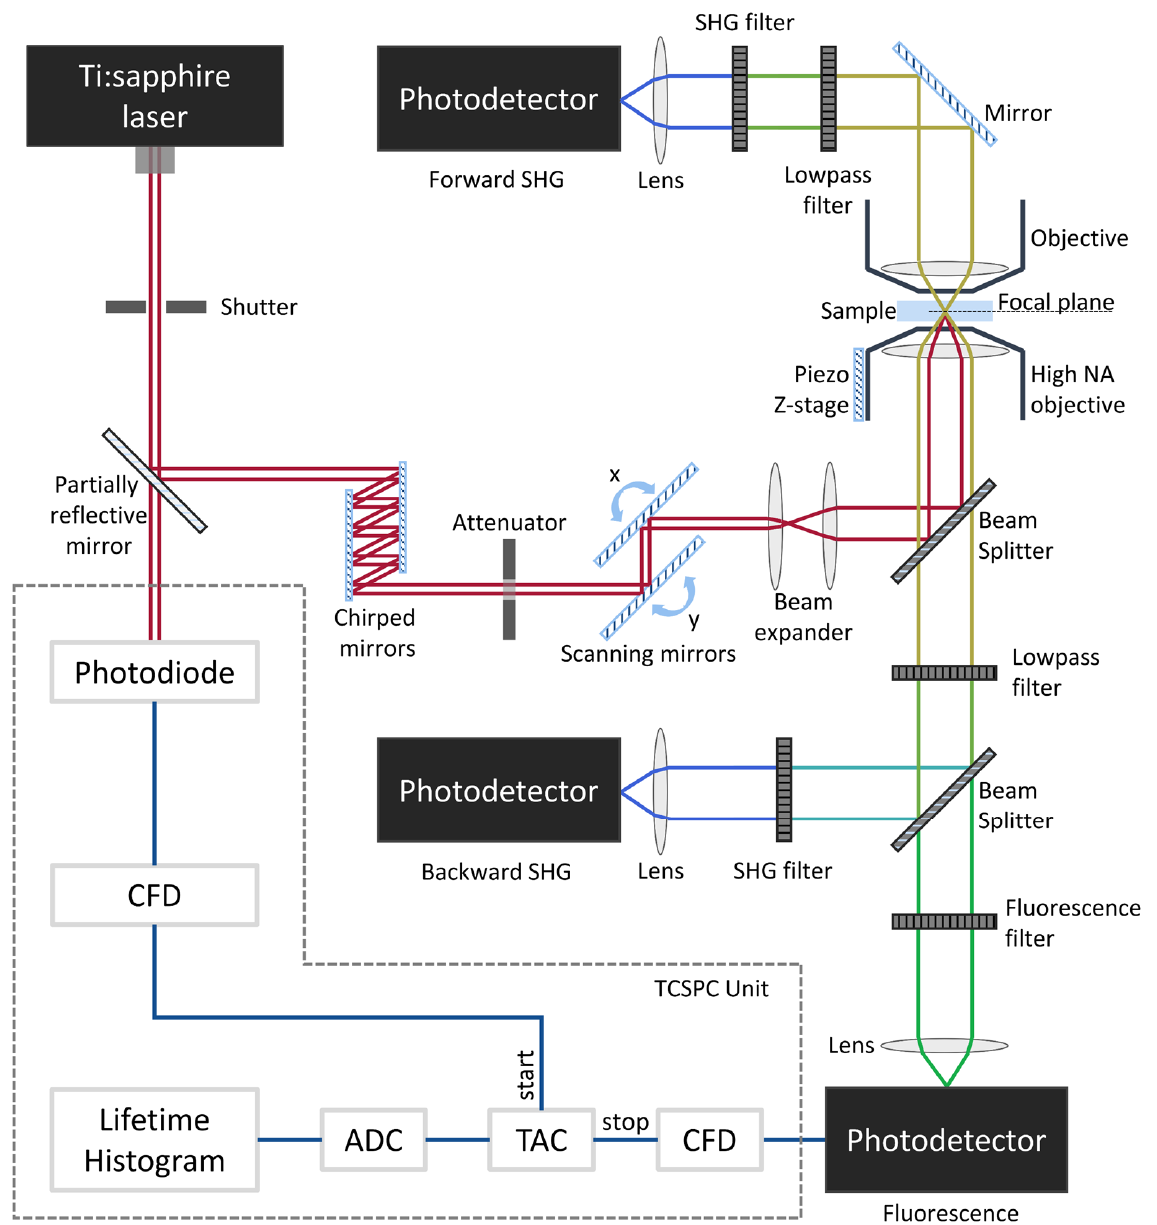
Figure 5. Schematic representation of the optical setup of a two-photon imaging microscope with multichannel detection combined with a time-correlated single photon unit for fluorescence lifetime imaging. CFD—constant fraction discriminator; TAC—time-to-amplitude converter; ADC—analog-to-digital converter.